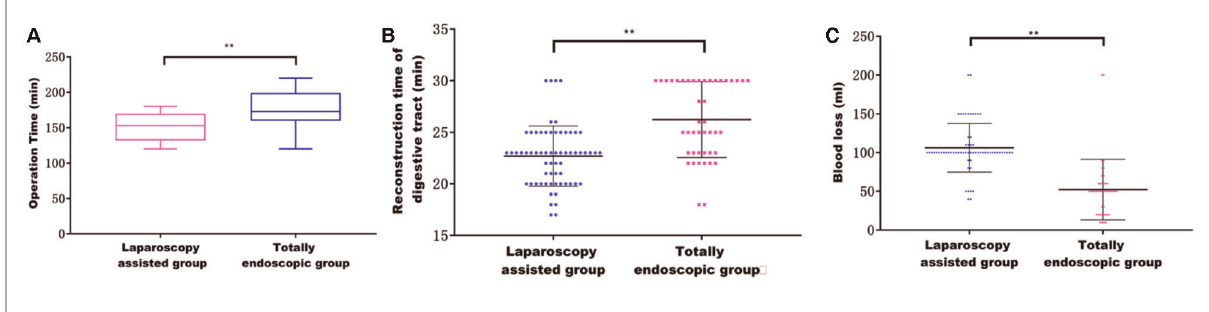
FIGURE 3 ( A ) Effect of different surgical methods on operation time; ( B ) effect of different surgical methods on the time of digestive tract reconstruction; ( C ) effect of different surgical methods on intraoperative blood